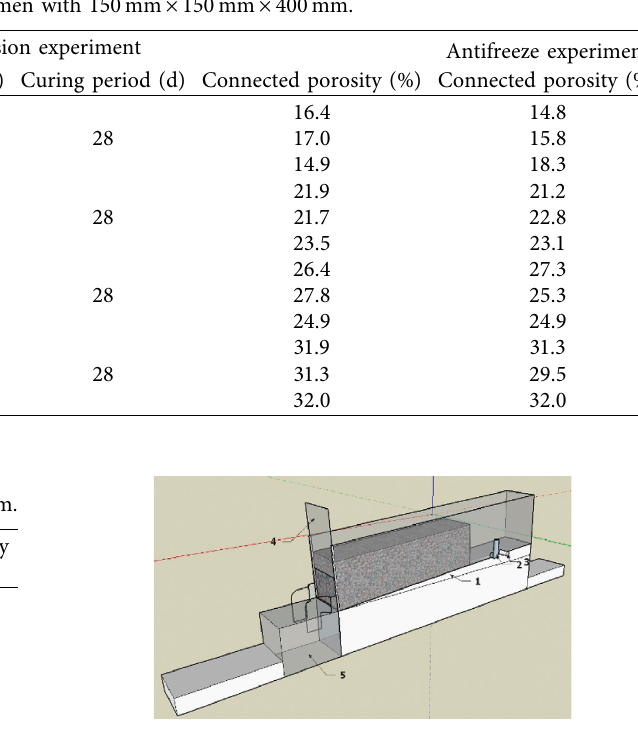
Figure 8: Schematic diagram of water permeability of porous